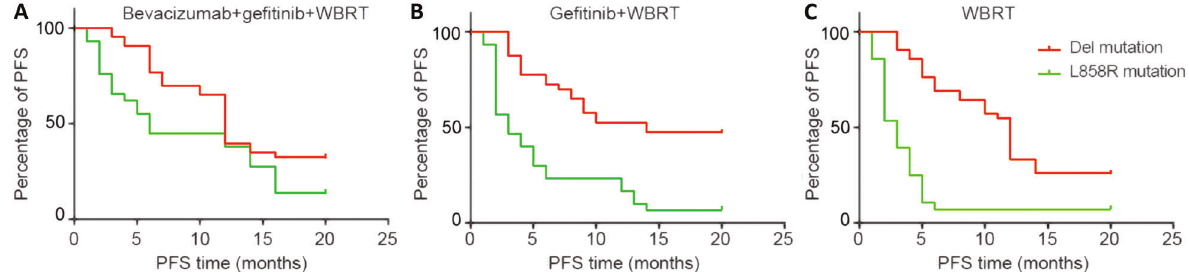
Figure 4. Kaplan-Meier estimation of progression-free survival in patients with brain metastases due to non-small-cell lung cancer with and without EFGR mutations treated with bevacizumab-ge fi tinib-WBRT, ge fi tinib-WBRT and WBRT. WBRT: whole brain radiotherapy.